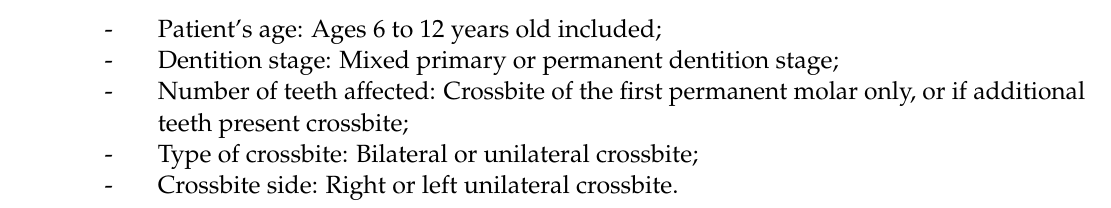
Maxillomandibular discrepancy: Difference between maxillary width and mandibular